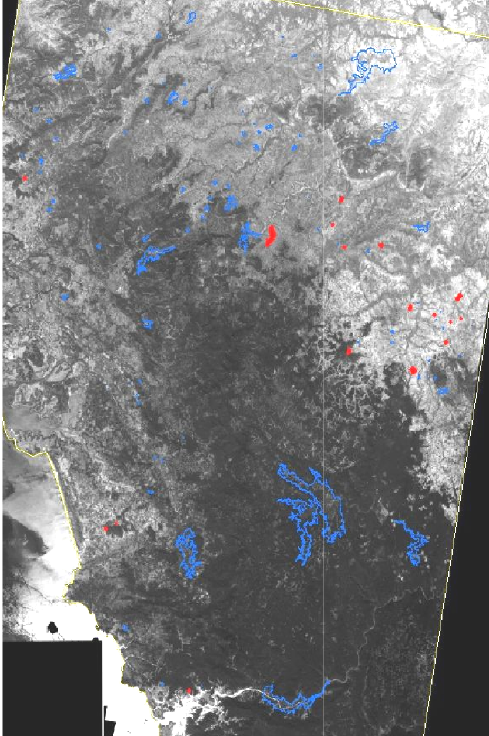
Figure 5 . Orientation of Hexagon data through RFM